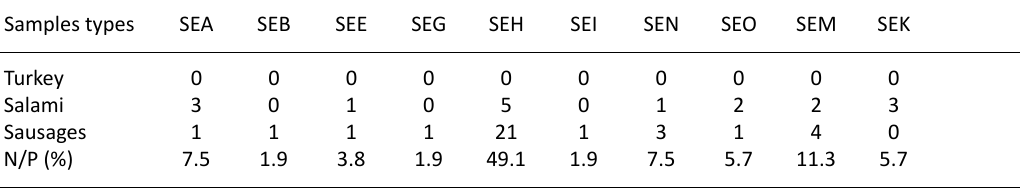
Table 4. The distribution of virulence enterotoxin genes among food samples collected from Riyadh, Saudi Arabia Samples